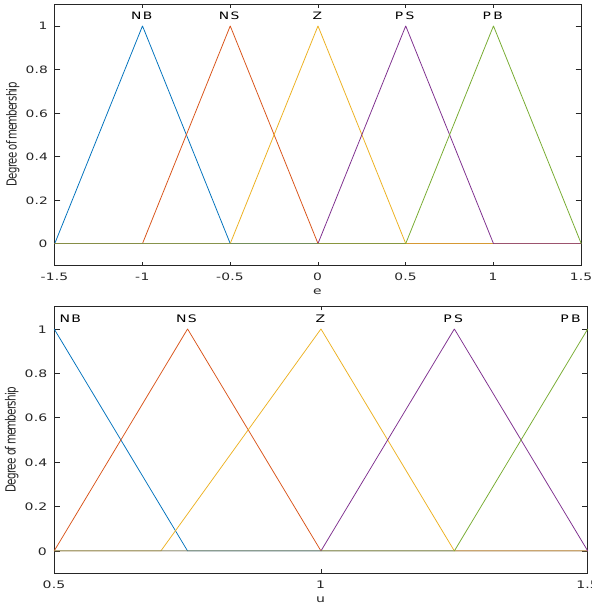
Figure 6. Input and output membership functions.